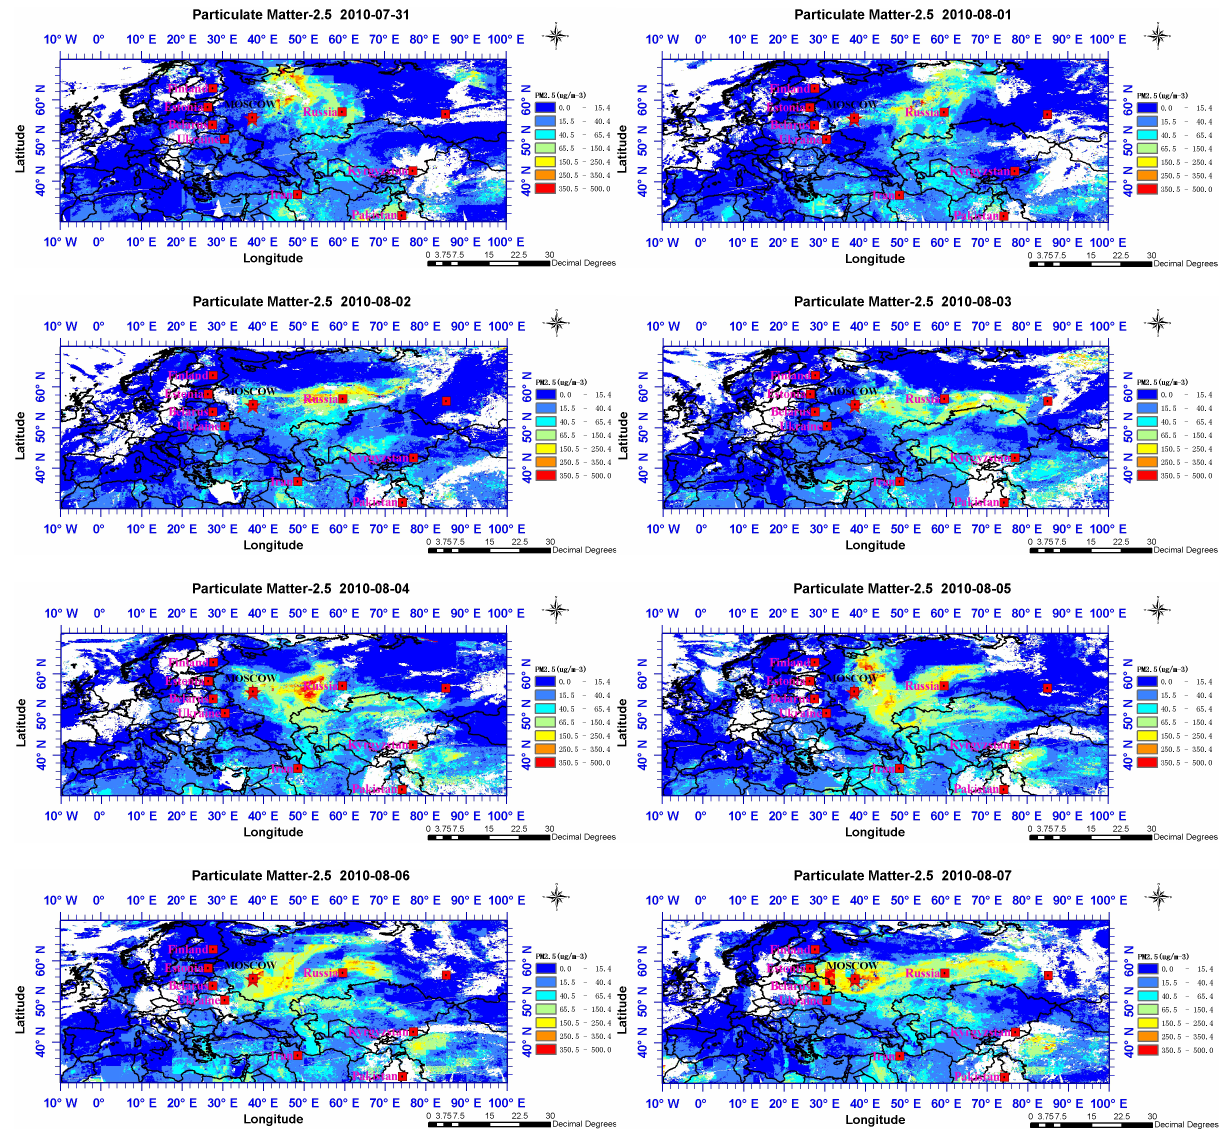
Fig. 5 PM 2 . 5 (in µgm − 3 ) distribution over the study area for the period from 31 July to 15 August 2010. The mean satellite-derived daily PM 2 . 5 concentrations were calculated from the methods as described in the